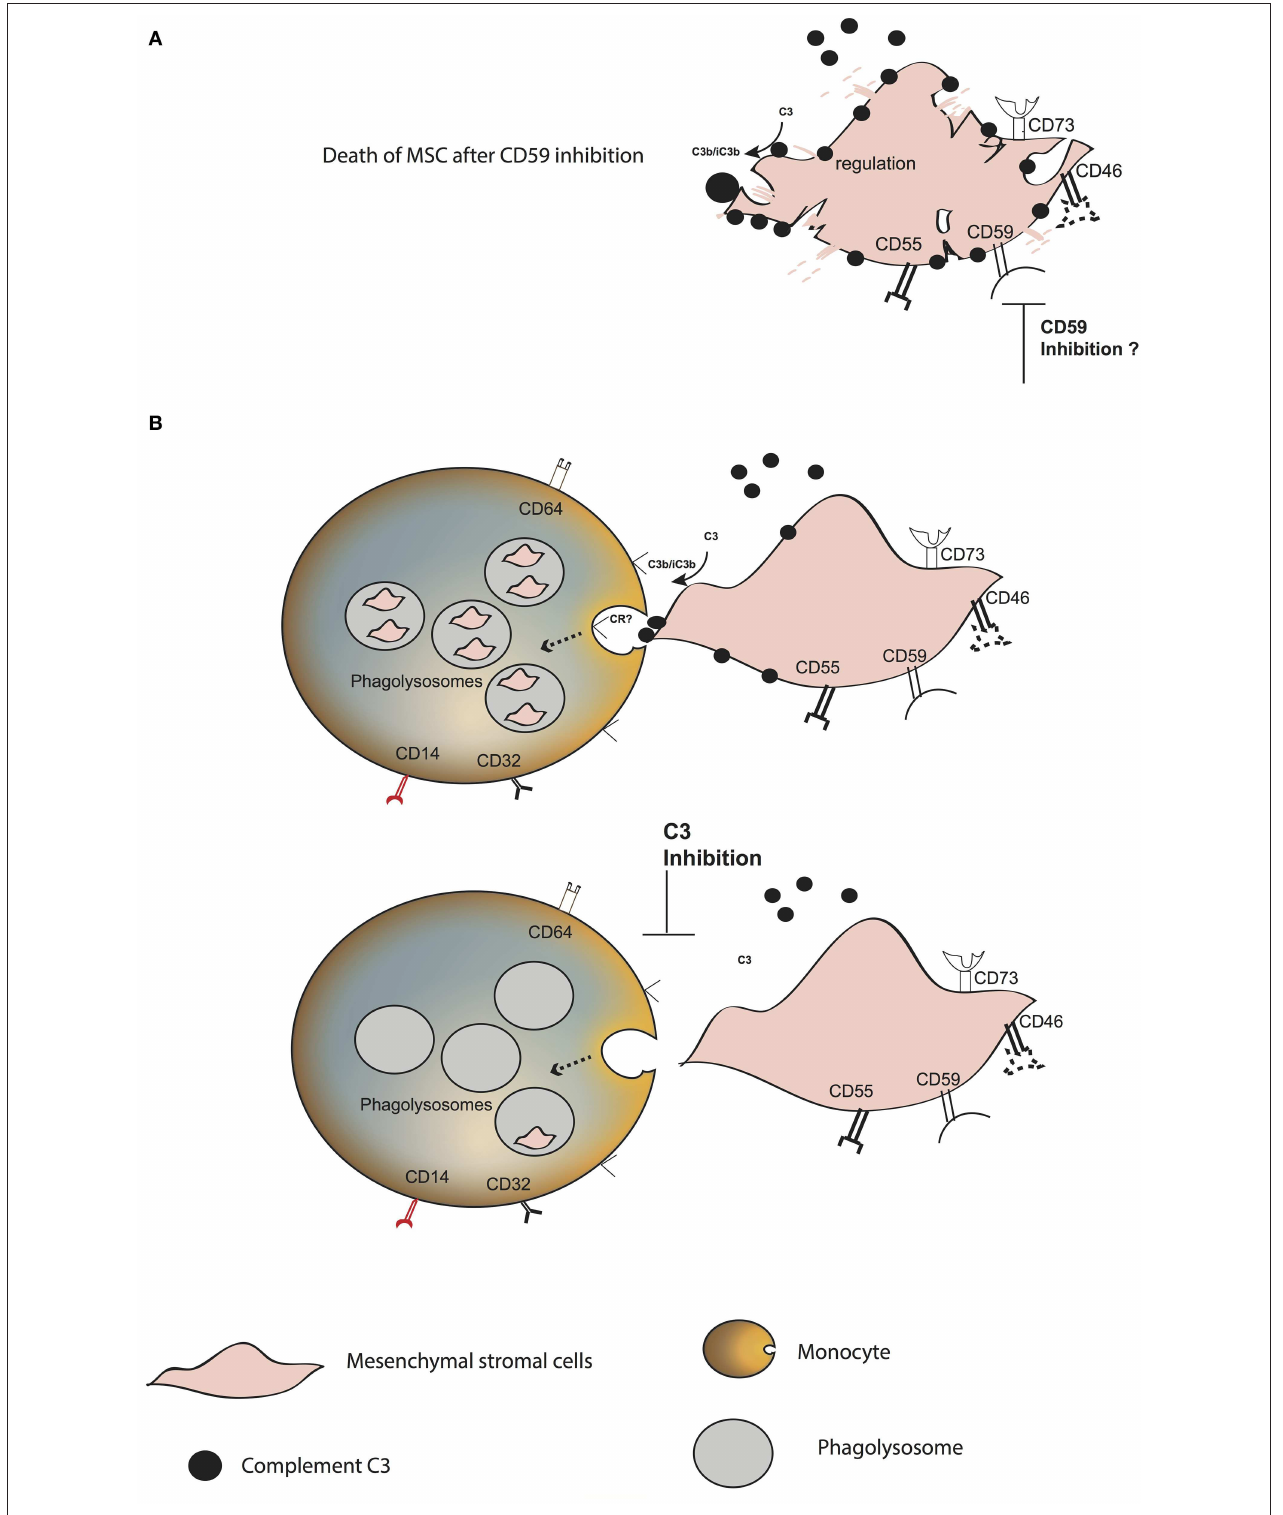
FIGURE 6 | Model of MSC fate after interaction with blood. (A) Increase in C3 binding and decrease in the survival of plasma pre-treated MSC in the presence of anti-CD59. (B) C3 binds to the surface of MSC, probably through the alternative complement pathway. CD59 blocks the membrane attack complex from forming. MSC are phagocytosed by classical and intermediate monocytes, mainly mediated by the presence of C3 on the MSC surface. The receptor binding to C3 and inducing the phagocytosis remains unknown.